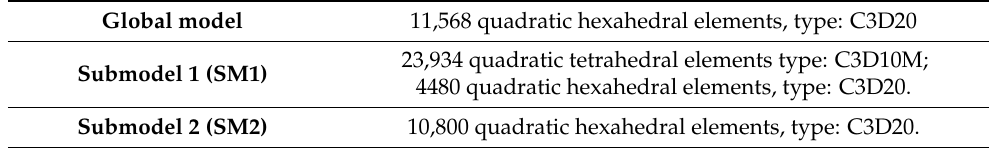
Table 4. The number and type of elements used in each